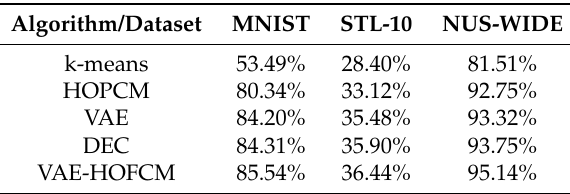
Table 1. Clustering accuracy of ACC.